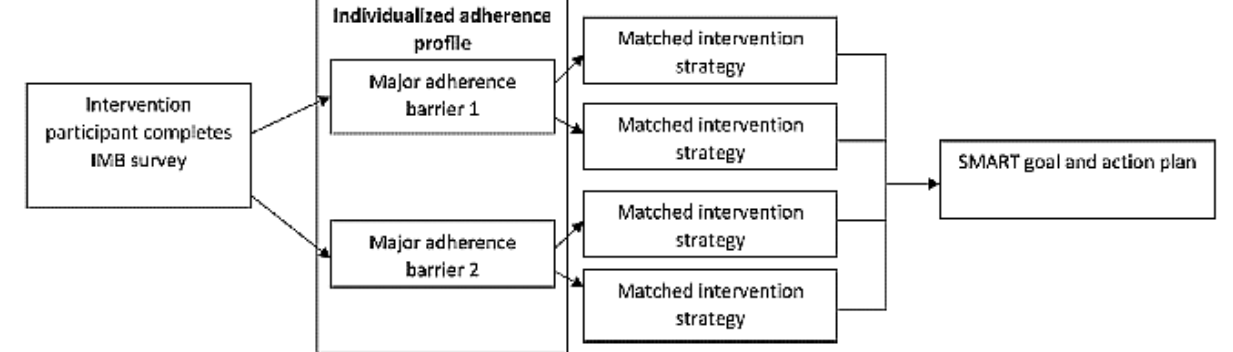
Figure 3. Intervention flow. SMART: specific, measurable, achievable, relevant,